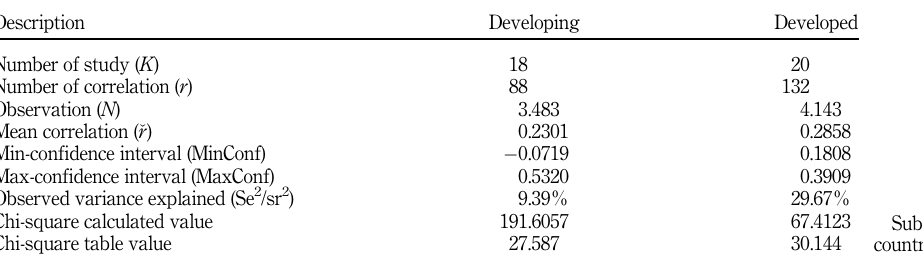
Table 2. Subgroup analysis